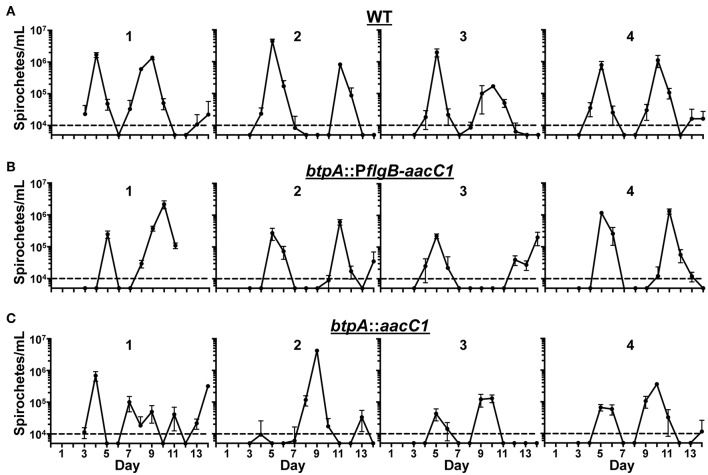
btpA is dispensable for mammalian infection. Groups of four mice were inoculated with a dose of 102 spirochetes of the following strains; (A) wild-type (WT), (B)
btpA::PflgB-aacC1, and (C)
btpA::aacC1. Blood was collected daily between days 3 and 14, and spirochetemic burdens were then quantified by qPCR. Numbers above the graphs identify the mouse in each of the experimental groups. The dashed line represents the limit of detection of this assay (104 spirochetes/mL), and error bars represent SEM.